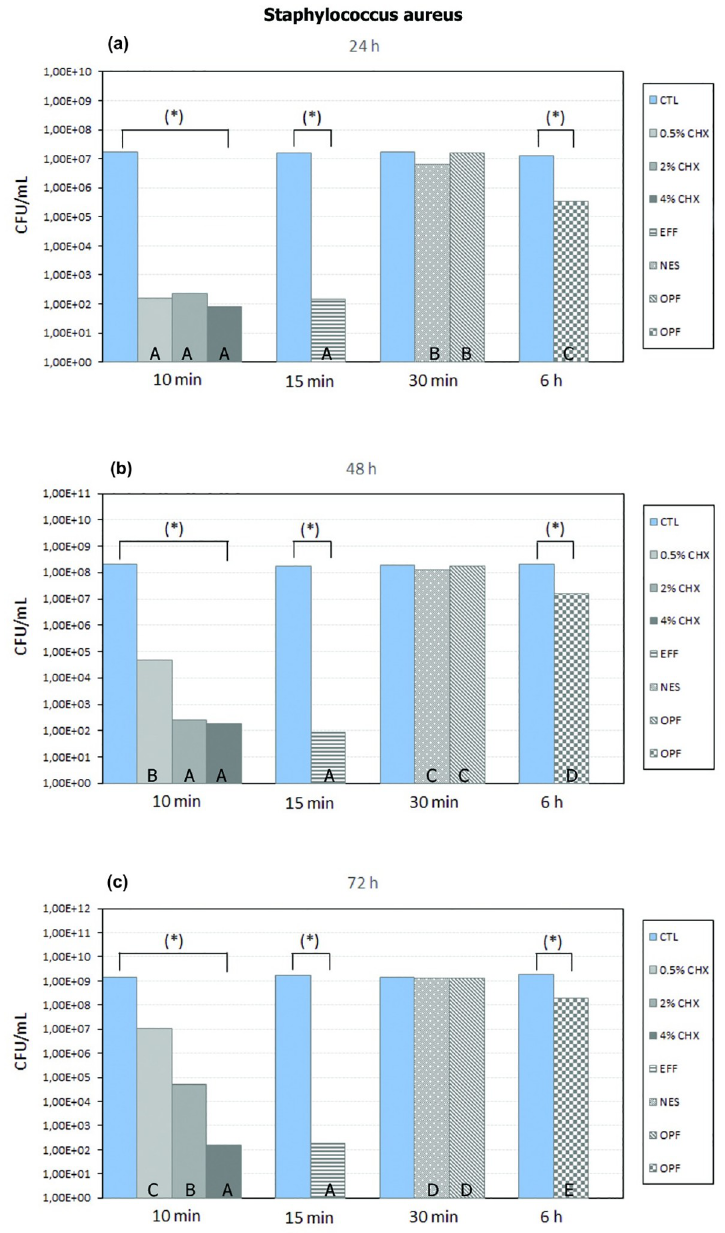
Fig 3. Tukey-Kramer HSD test with a level of significance of 5%. Mean (number of CFU/mL of Staphylococcus aureus ) of each control group and each disinfectant group in 24 h (a), 48 h (b) and 72 h (c) of biofilm development. For a comparison only between control group and disinfectant group in each biofilm development period (individually), � means that there is a statistical difference between control group and disinfectant group ( P < 0.05). For a comparison only between disinfectant groups in each biofilm development period (individually), different letters represent a statistically significant difference ( P <